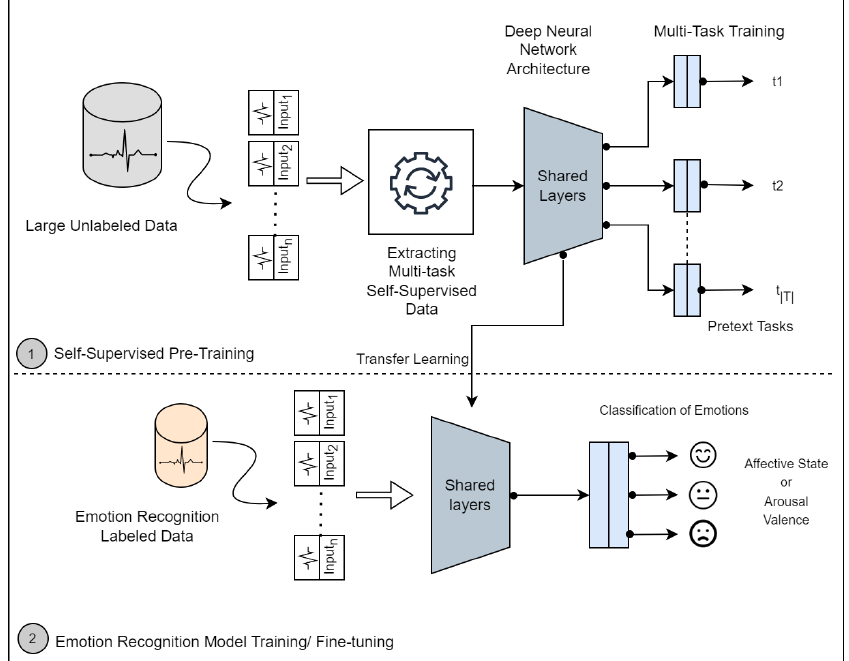
Figure 4. Overview of the self-supervised approach for emotion classification. The idea is to train a deep neural network to recognize signal transformations (i.e., pretext tasks), as shown in Step 1. The learned knowledge is transferred to an emotion recognition model (Step 2) to improve the detection